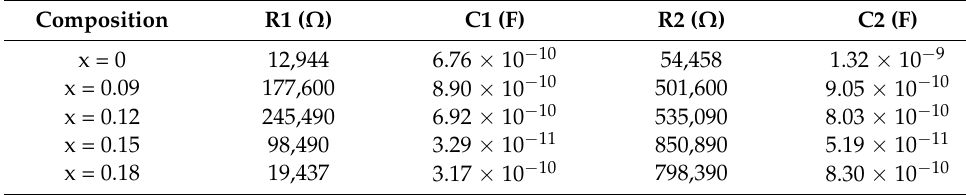
Table 2. Fitted values of equivalent circuit model for Nyquist